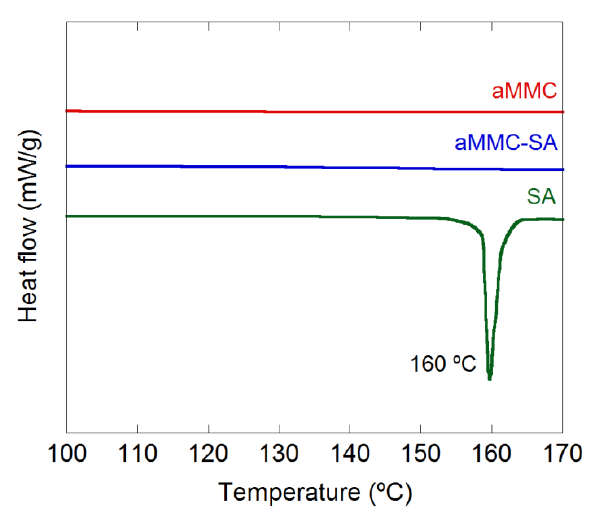
Figure 4. DSC thermograms for aMMC, aMMC–SA, and pure SA.